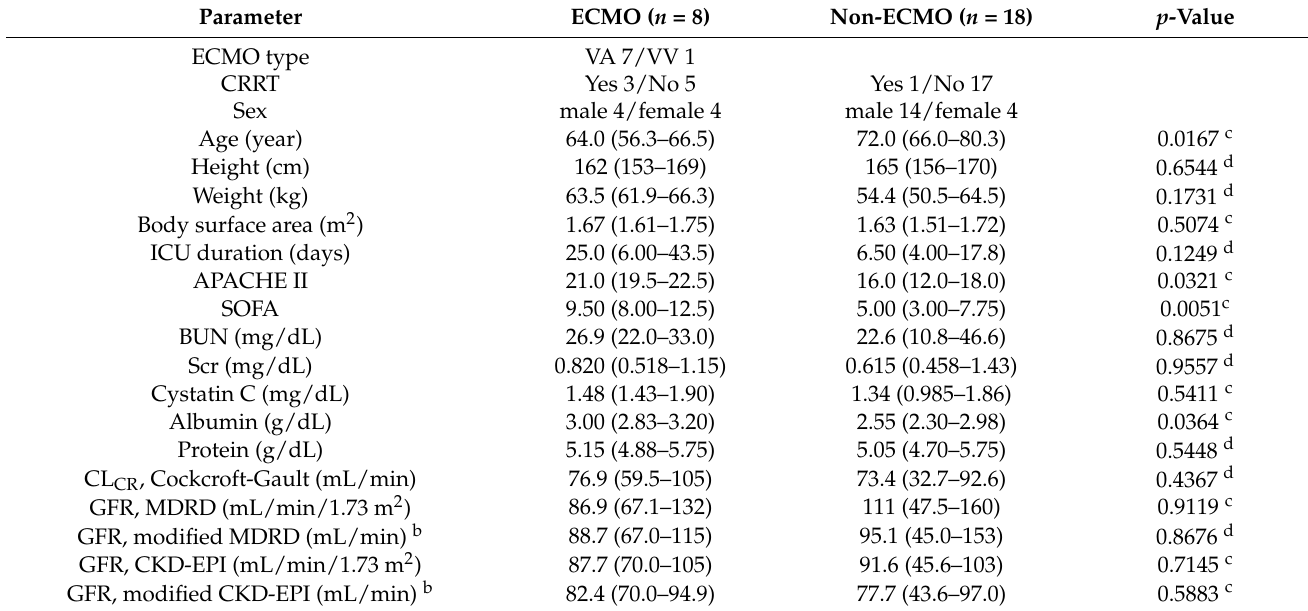
Table 1. Patients’ characteristics (median